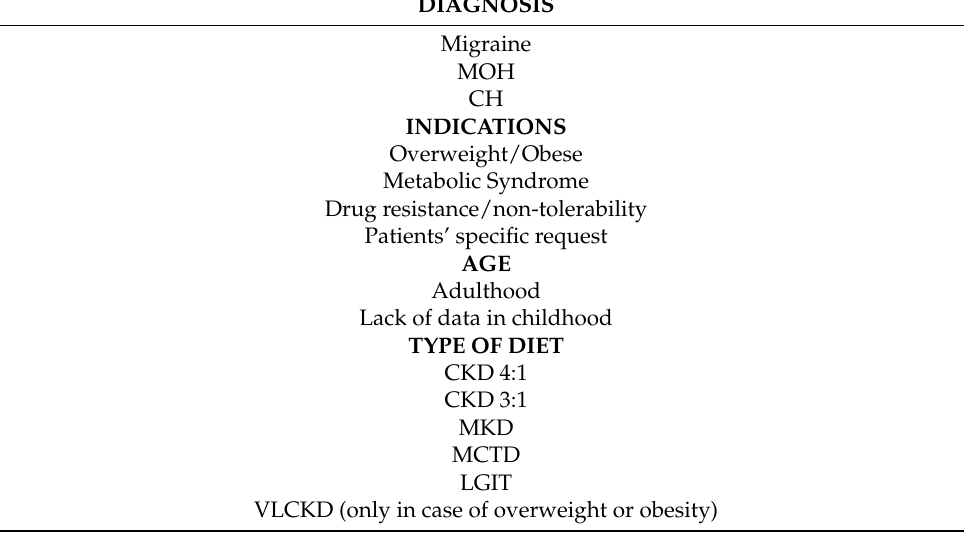
Table 1. Overview of